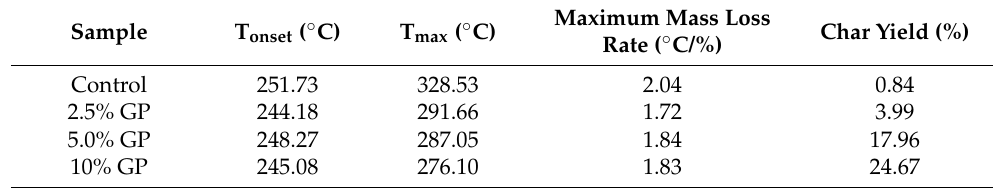
Figure 3. TG ( a ) and DTG ( b ) cures of unmodified wood and GP-modified wood under air atmosphere. Table 1. Thermal degradation data of control wood and GP-modified wood.